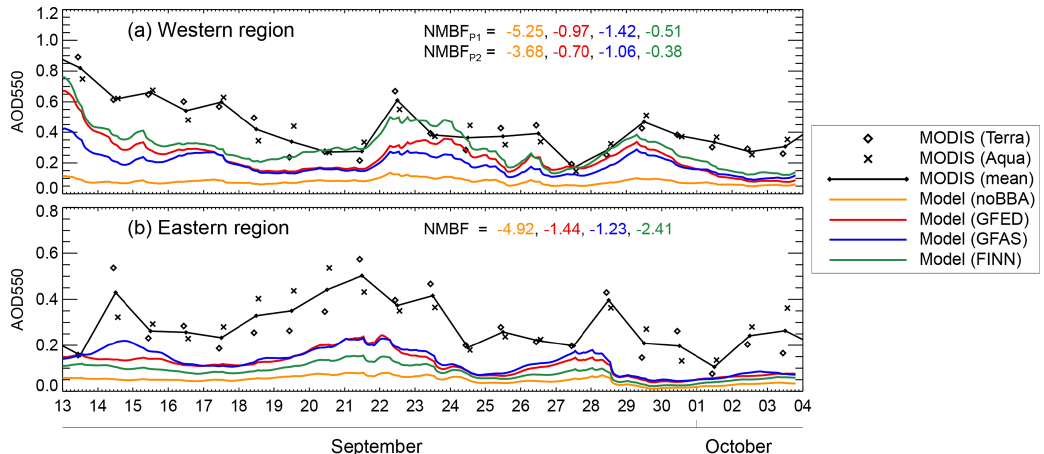
Figure 7. Time series of simulated (colour) and observed (black) aerosol optical depth at 550nm (AOD550) for the SAMBBA campaign (13 September–3 October 2012) over (a) the western Amazon (6–12 ◦ S, 54–68.5 ◦ W) and (b) the eastern Amazon (4.5–15 ◦ S, 43–50 ◦ W). Observed AOD550 retrieved by MODIS on board Terra (overpass time 10:30LT) is shown by the black diamonds and AOD550 retrieved by MODIS on board Aqua (overpass time 13:30LT) is shown by the black crosses; the black line shows an average value for each day (plotted at midday local time). Simulated hourly AOD550 (plotted at local time for Rondônia, Brazil: UTC − 4h) is shown for the model with FINN1.5 (green), GFAS1.2 (blue), GFED4 (red) emissions and with no biomass burning emissions (noBBA; orange). The NMBF values are given separately for the western region (Phase 1 and Phase 2) and eastern region in Table